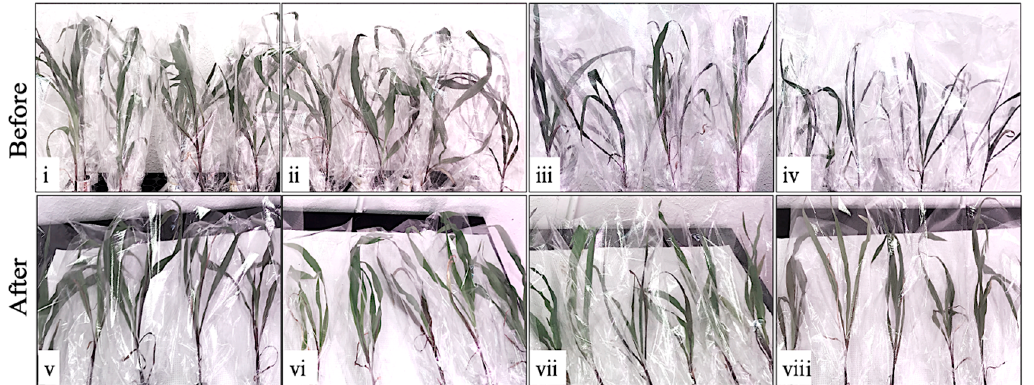
Figure 1. Effect of Dalbulus maidis , drought, and combined stress on the above-ground performance of maize. Images of seedlings exposed to D. maidis , drought, and combined stress treatments: im- ages ( i , v ) are control, images ( ii , vi ) are D. maidis -only, images ( iii , vii ) are drought-only, images ( iv , viii ) are combined stress ( D. maidis and drought stress), images ( i – iv ) also show the observed drought symptoms ( ± wilting, leaves rolling) on the 3rd day of absolutely no watering at the 21-day point of progressive stress, while images ( v – viii ) show recovery 1 day after re-infiltrating the symp- tomatic seedlings.